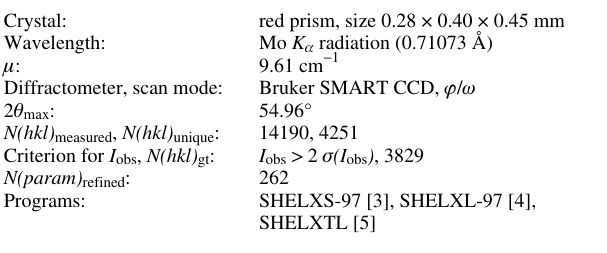
Table 1. Data collection and handling.